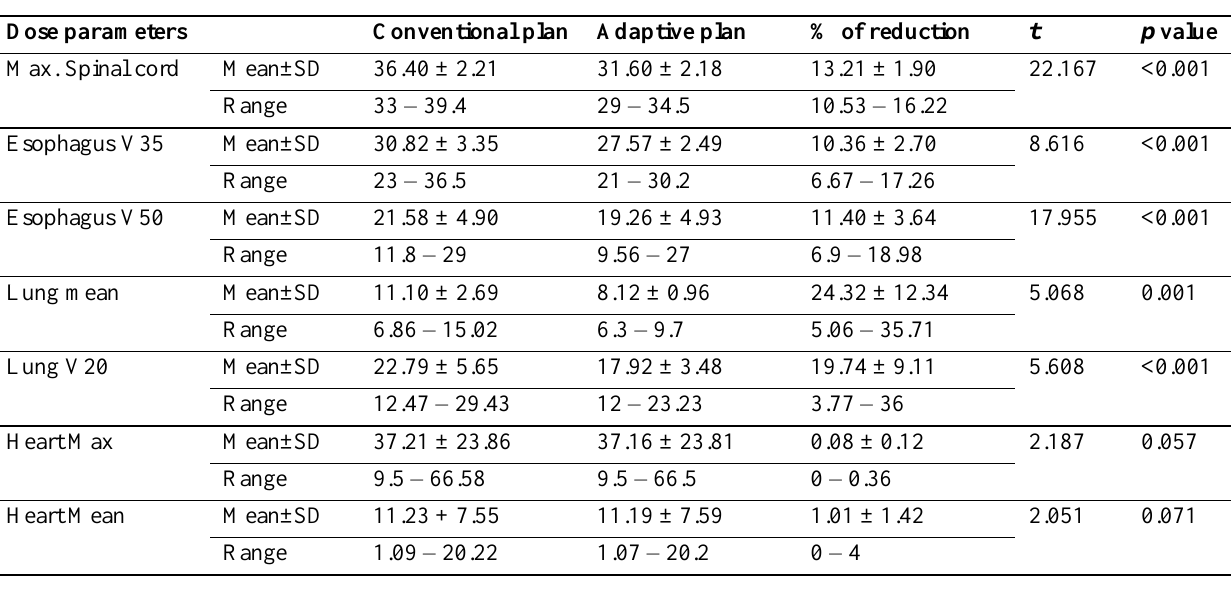
Table 3. Change in doses to organs at risk with adaptive plan Dose